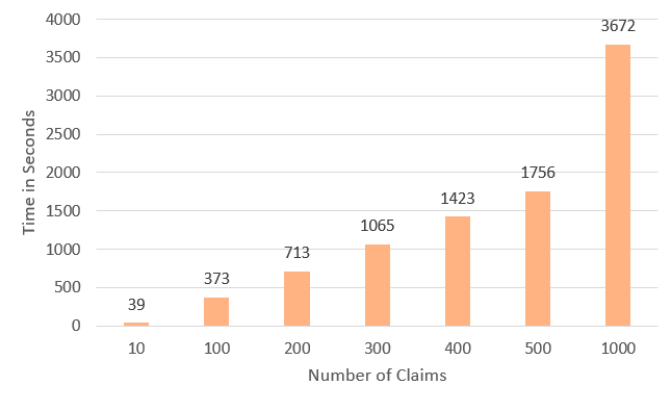
Figure 11. Time needed to process the different batch files.